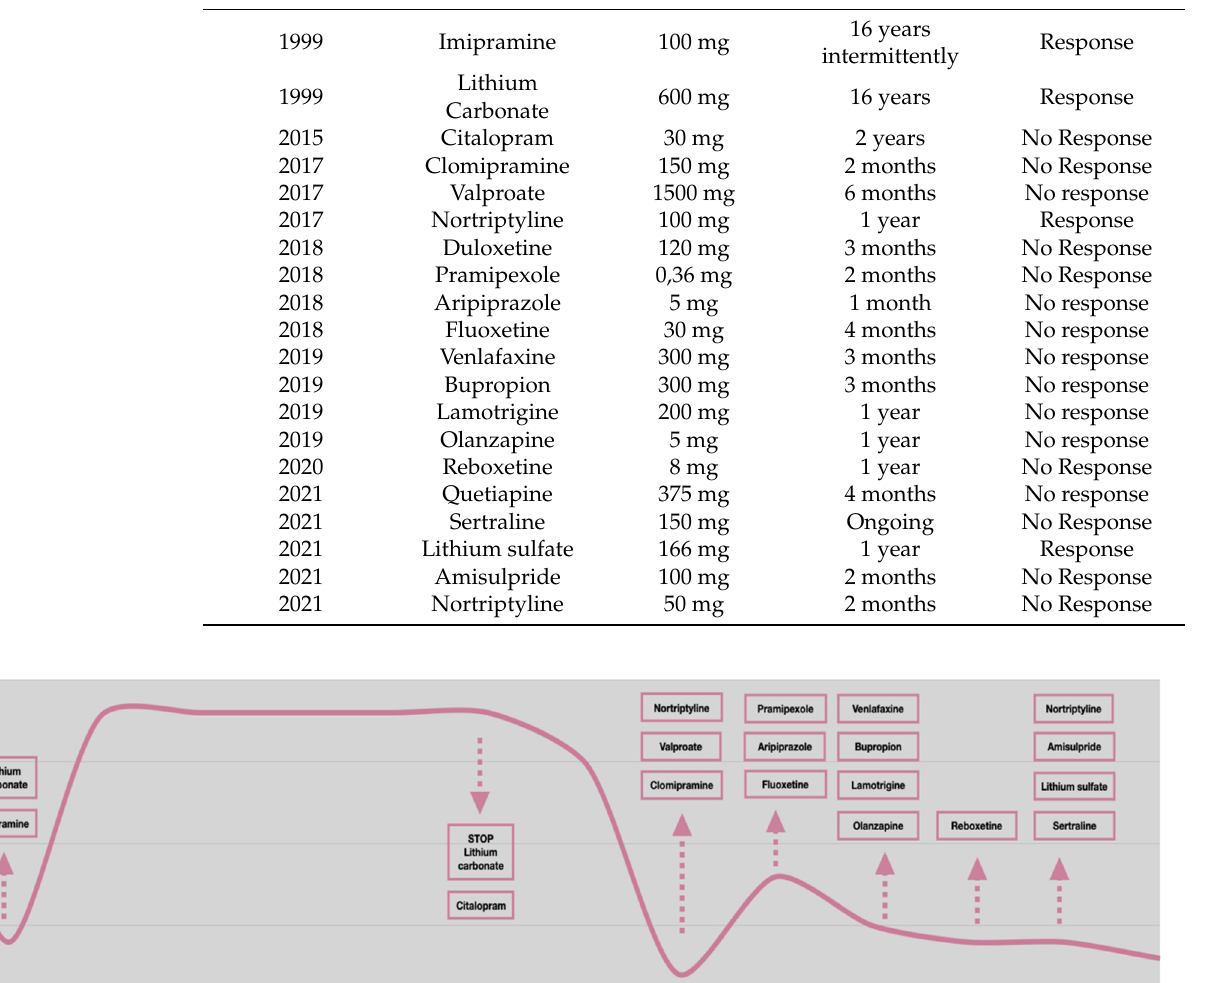
Table 6. Psychometric assessment at first consultation.